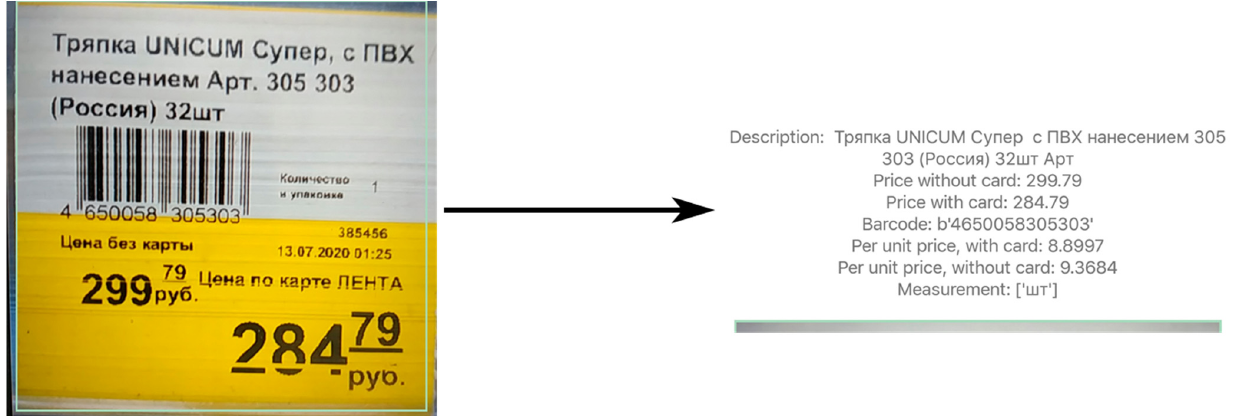
Figure 13. Client–server application